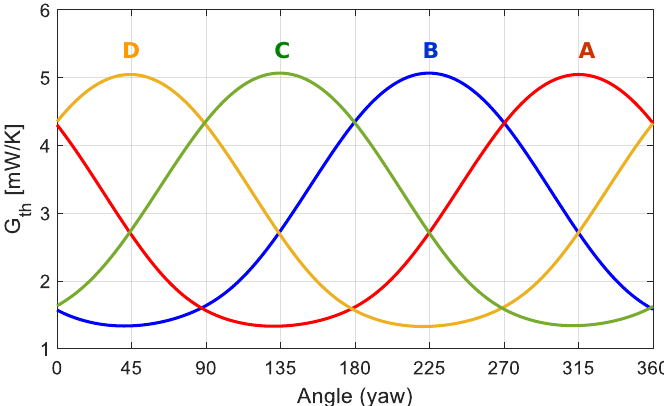
Figure 22. Evolution with the yaw angle of the average convective heat transfer coefficient G th of each sector of the sphere at Re = 1000. These values have been obtained by integration from DNS results. Sector names correspond to those defined in Figure 21. The disposition of the sectors A, B, C and D is the same the one shown previously.